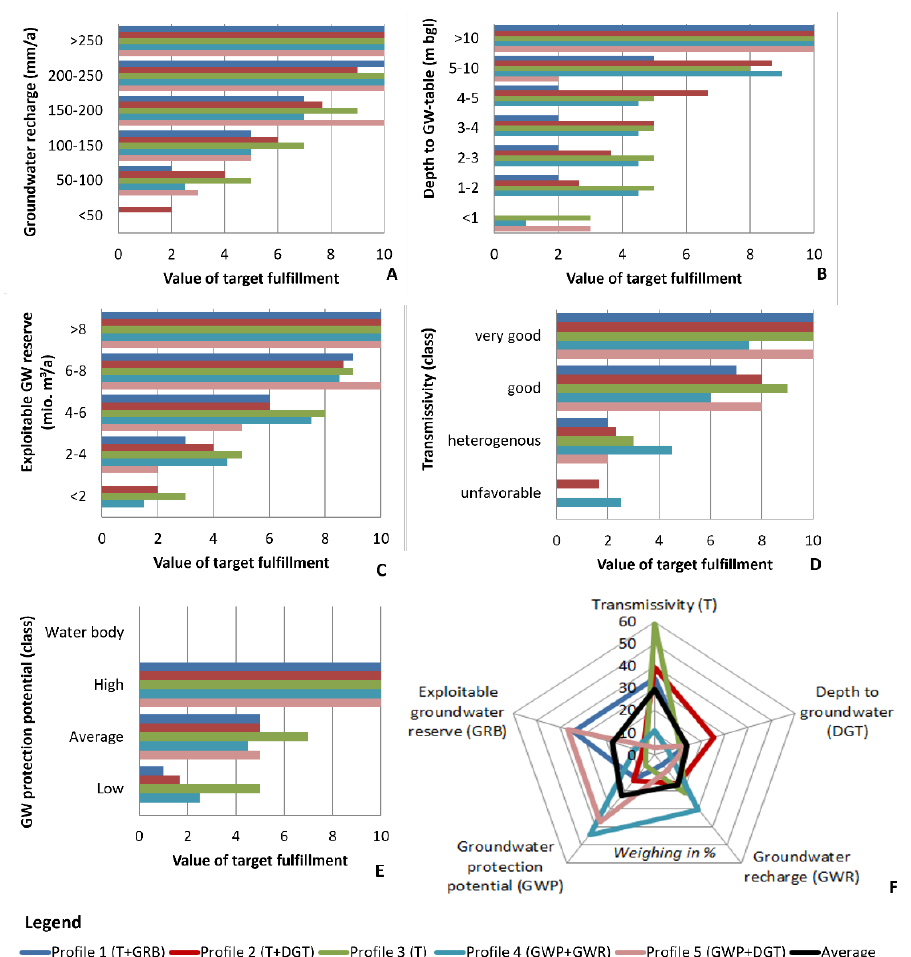
Figure 4. Characteristics of the developed rating profiles (0 = insufficient site conditions, 10 =